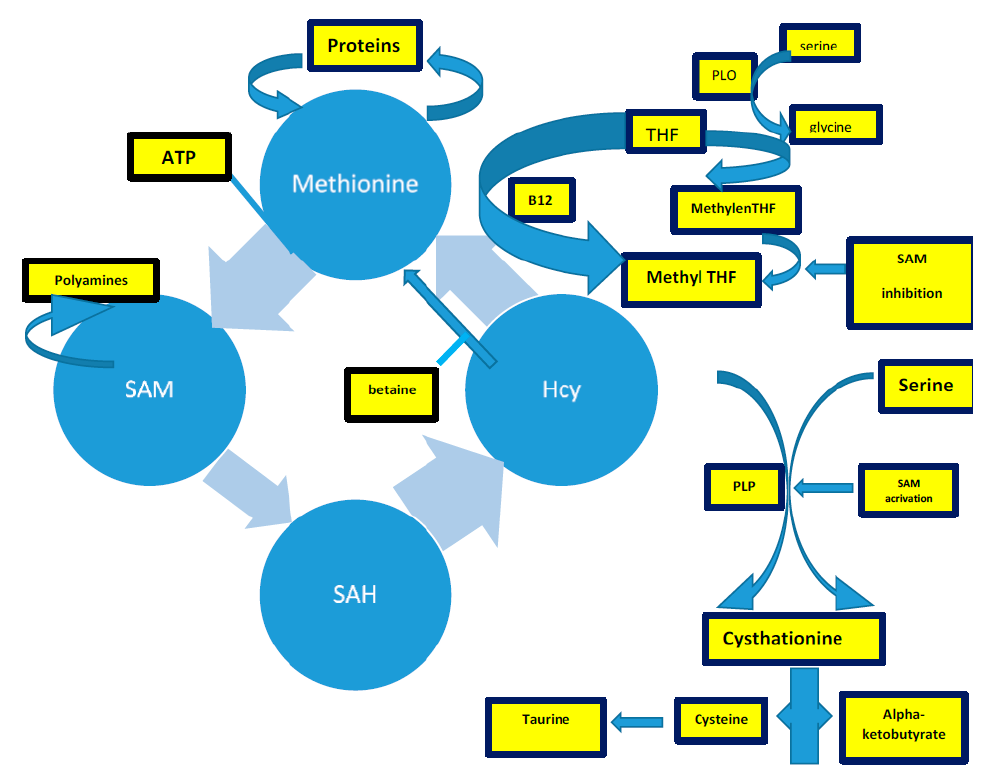
Figure 3. The complex of Hcy production, described in the text. Acronyms: SAM: s-adenosylmethionine; THF: tetrahydrofolate; PLP: pyridoxal-5-phosphate.